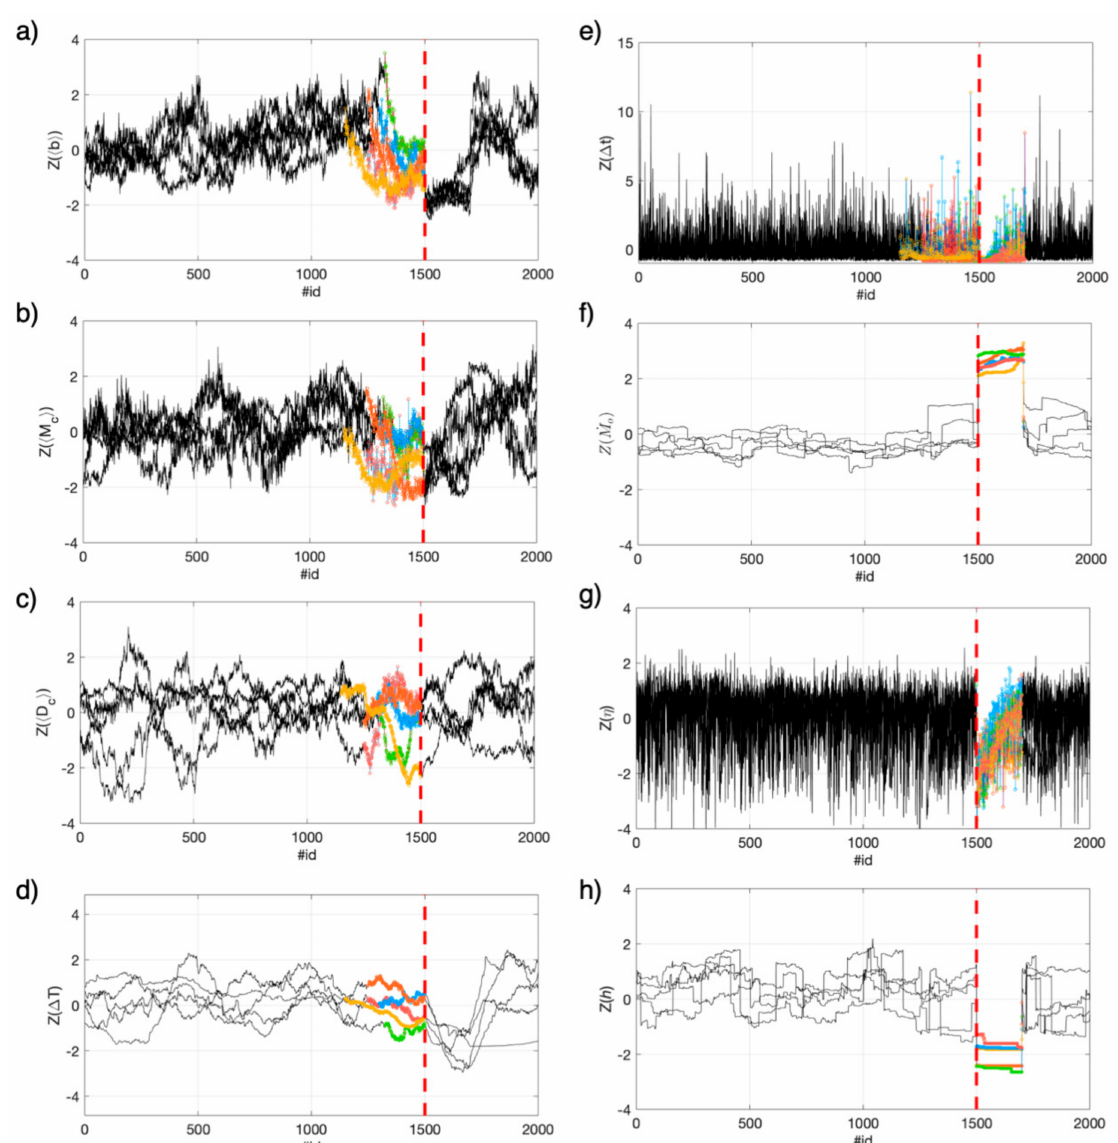
Figure 5. Features belonging to the training M4 series after standardization. Background seismicity (black), foreshocks and aftershocks (colored per event). Time of the M4s occurrence (vertical, dashed red line). Subplots show different features according to Figure